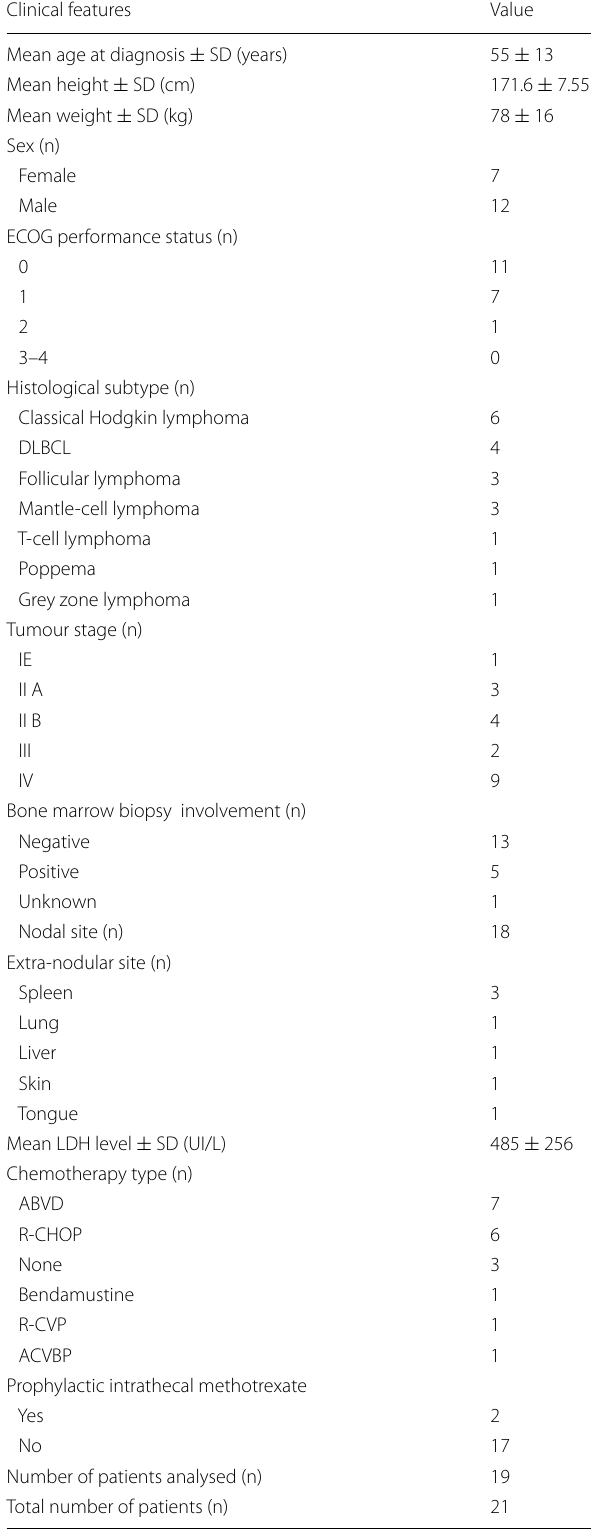
Table 1 Baseline characteristics of included patients Clinical